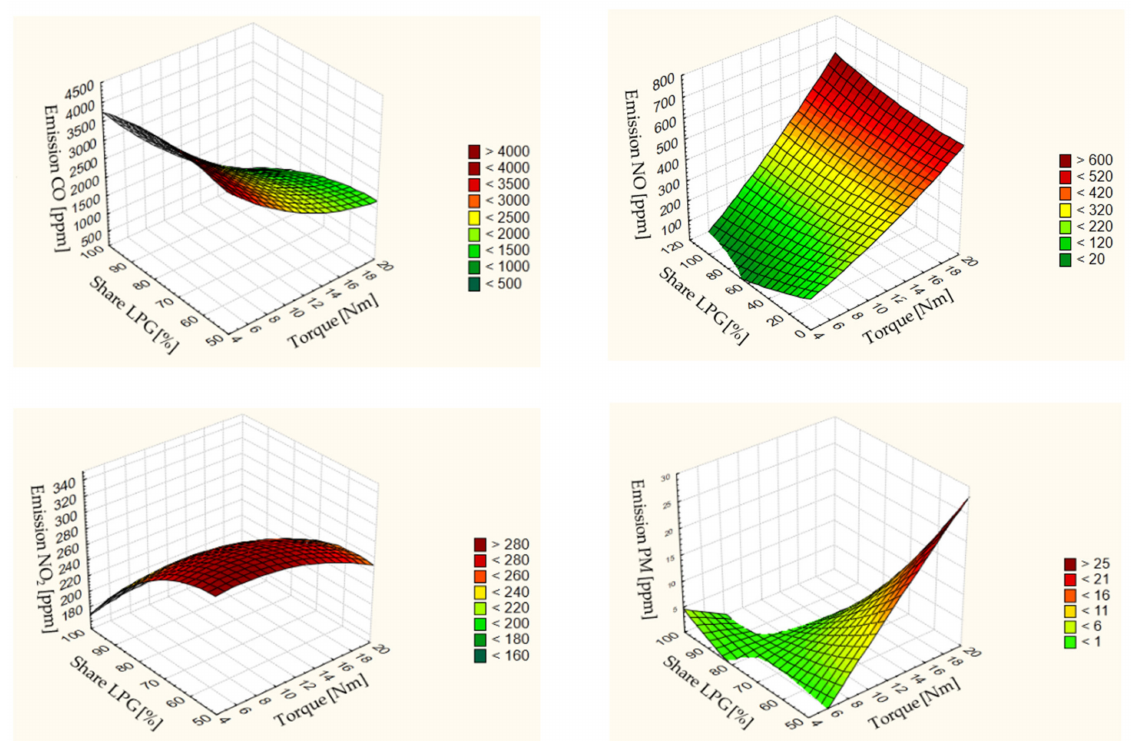
Figure 5. Emission of CO, NO, NO 2 , and PM in the mixture of DF and LPG at variable load.